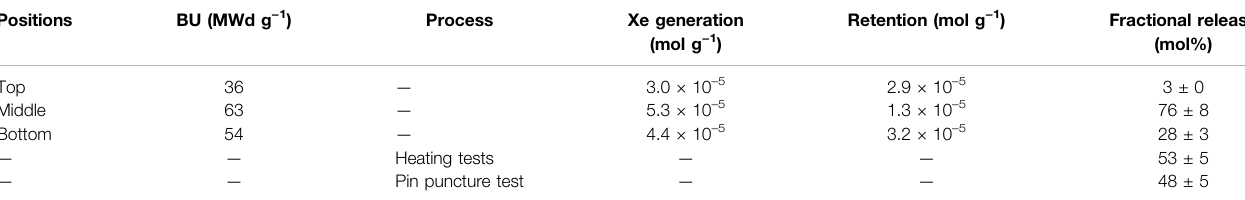
TABLE 3 | Amount of generated, retained and released gases (Sato et al.,